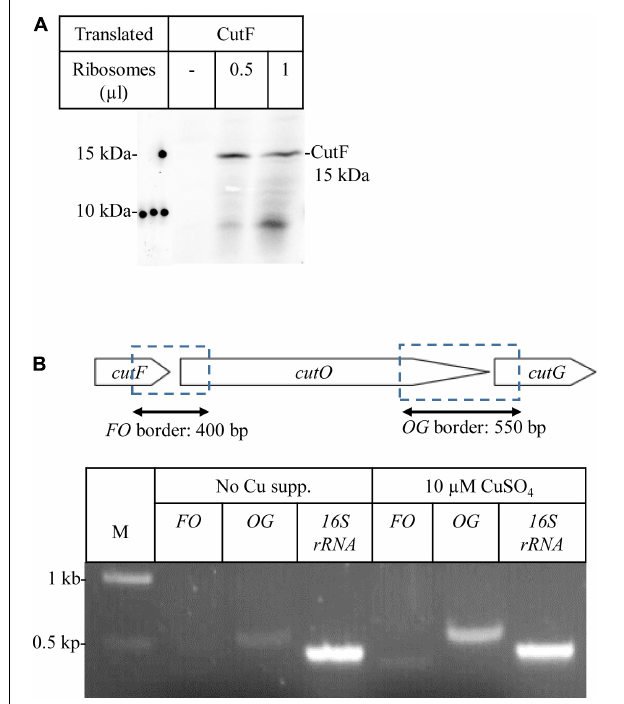
FIGURE 4 | CutF is translated into protein (A) In vitro protein synthesis of CutF. After in vitro synthesis, samples were separated by SDS-PAGE, and the radioactively labeled bands were detected by phosphorimaging. Different volumes ( µ l) of purified Escherichia coli ribosomes were used for in vitro synthesis (B) Transcriptional analysis of the cutFOG operon. Physical map of the cutFOG operon (upper cartoon representation) indicating the DNA fragments emerging from RT-PCR (double arrow). RT-PCR analyses of cutFOG mRNA levels in cutFOG2 / (cid:49) cutFOG cells grown on MPYE without and with 10 µ M Cu 2 + supplementation. The 16S ribosomal RNA (450 bp) was used as an internal control. The intensities of the bands were determined by the ImageJ software. A negative control PCR omitting templates was performed in each case to check for DNA contamination (data not